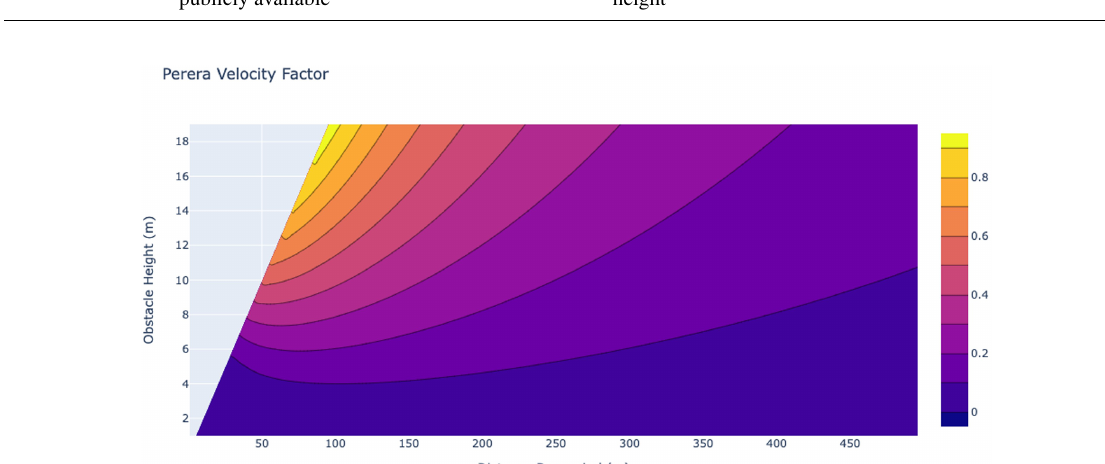
Wind Energ. Sci., 7, 1153–1169,